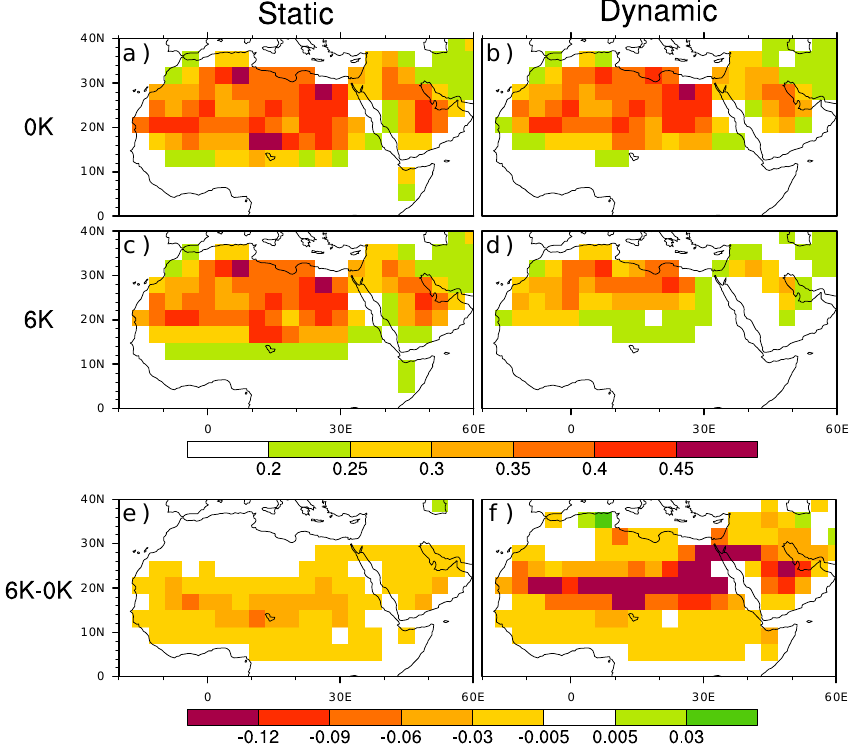
Fig. 2. Land surface albedo α S averaged over 100 years for (a) 0K st, (b) 0K dyn, (c) 6K st, (d) 6K dyn. 100-year mean land surface albedo differences between (e) 6K st and 0K st, (f) 6K dyn and 0K